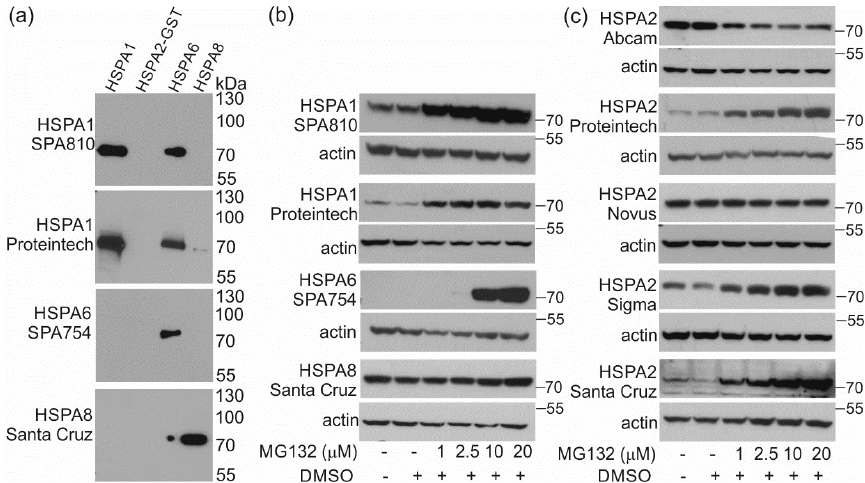
Figure 3. Response of HSPAs system to proteotoxic stress in MCF7 cells exposed to MG132 proteasome inhibitor. ( a ) Reactivity of antibodies used for detection of stress-inducible HSPA1 and HSPA6 and constitutive HSPA8 proteins against human recombinant HSPA1, HSPA2-GST, HSPA6 and